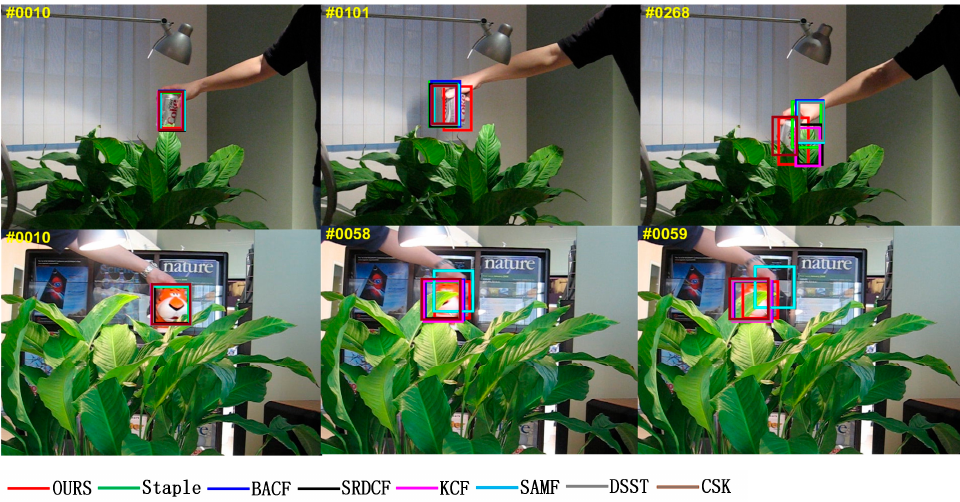
Figure 7. Visual comparison with eight trackers in the “Coke” and “Tiger2” video sequences in an occlusion challenge scenario.